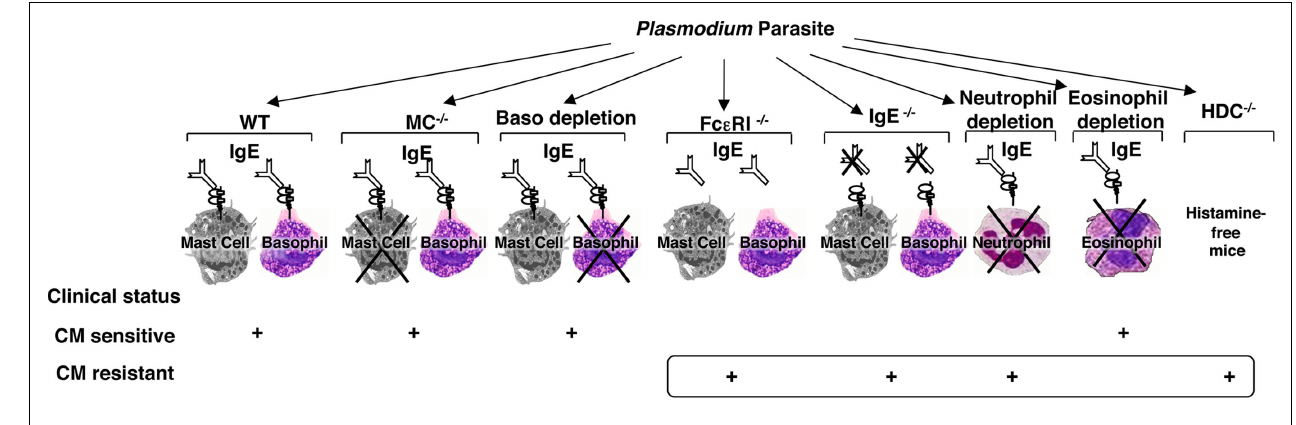
mediators released upon activation of these cells, and granulocytes such as neutrophils and eosinophils, was explored individually using either mutant mice (IgE − / − , CD117 − / − , Fc ε RI α − / − , HDC − / − ) or antibody-based depletion procedures (for basophils using the Ba103 mAb, for neutrophils using the NIMP-R14 mAb, and for eosinophils anti-Siglec-F Ab). Each component of this cascade tested gave rise to either a sensitive or resistant phenotype with regard to cerebral